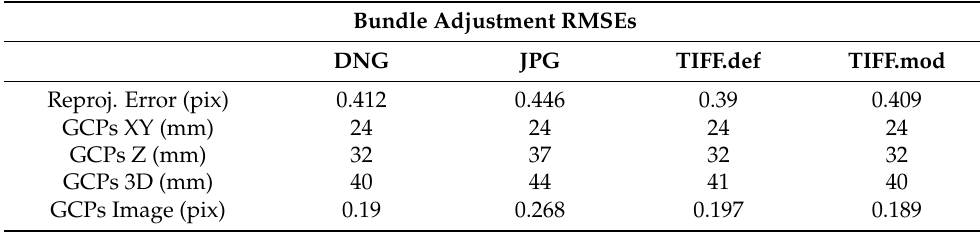
Table 3. Agisoft Metashape tie points and markers root mean square errors of each image